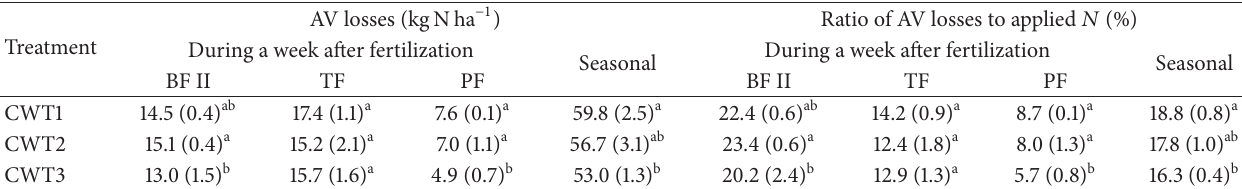
Table 2: Ammonia volatilization losses from CWT1, CWT2, and CWT3.